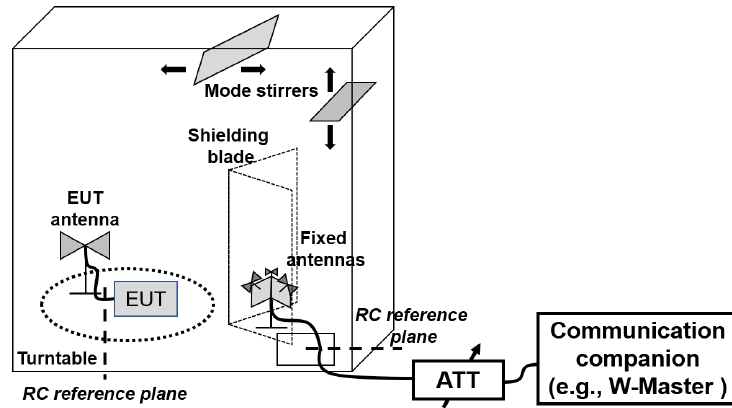
Figure 1. Sketch of the measurement setup.